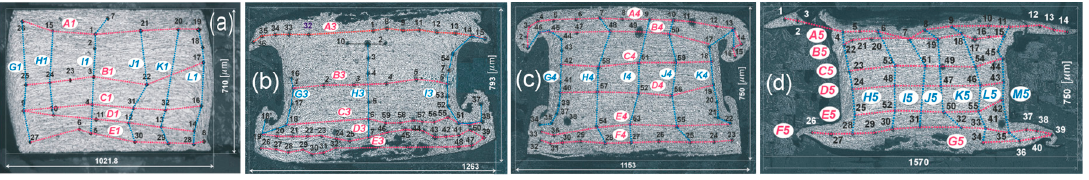
Figure 9. Metallographic cross-sections of samples: ( a ) Free upsetting; ( b ) UOM with a die CC; ( c ) UOM with a die FC; and ( d ) UOM with a die JC.